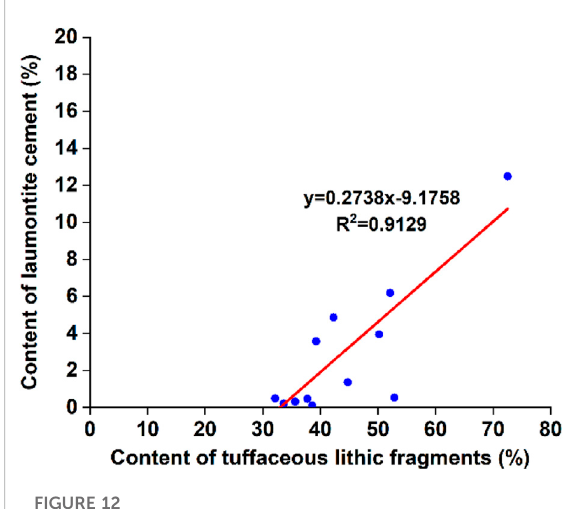
FIGURE 12 Relationship between contents of tuffaceous lithic fragments and laumontite cement in the P 3 w reservoir in Fukang